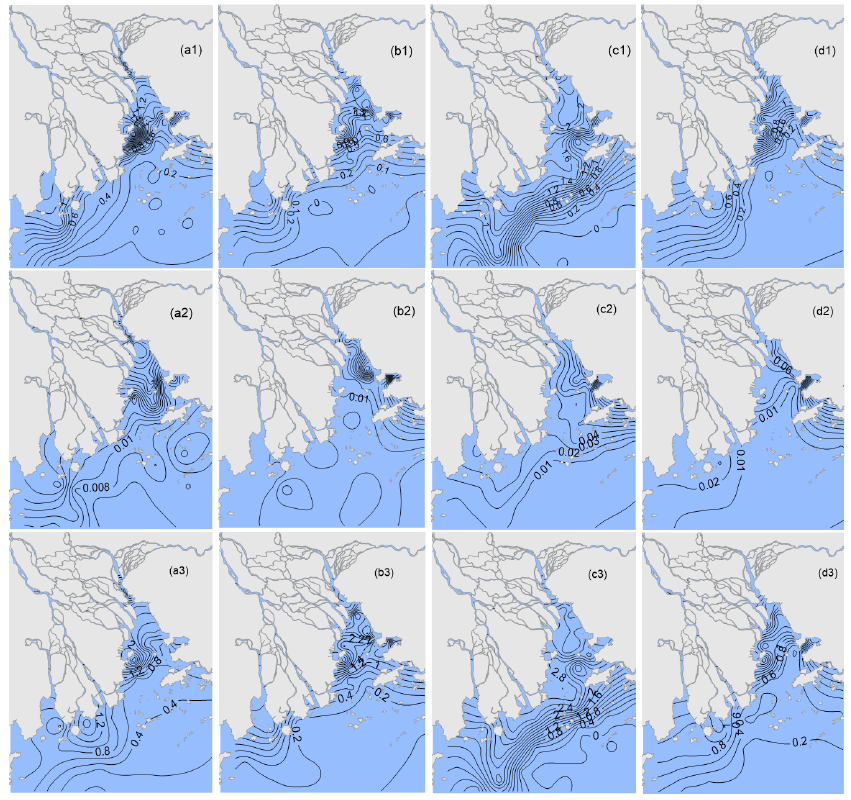
Figure 4. Spatial distributions of dissolved inorganic nitrogen ( a1 – d1 ), dissolved phosphorus ( a2 – d2 ), and dissolved silicate ( a3 – d3 ) at the surface layer in the Pearl River estuary, unit: mg/L (( a ) February; ( b ) May; ( c ) August; ( d )